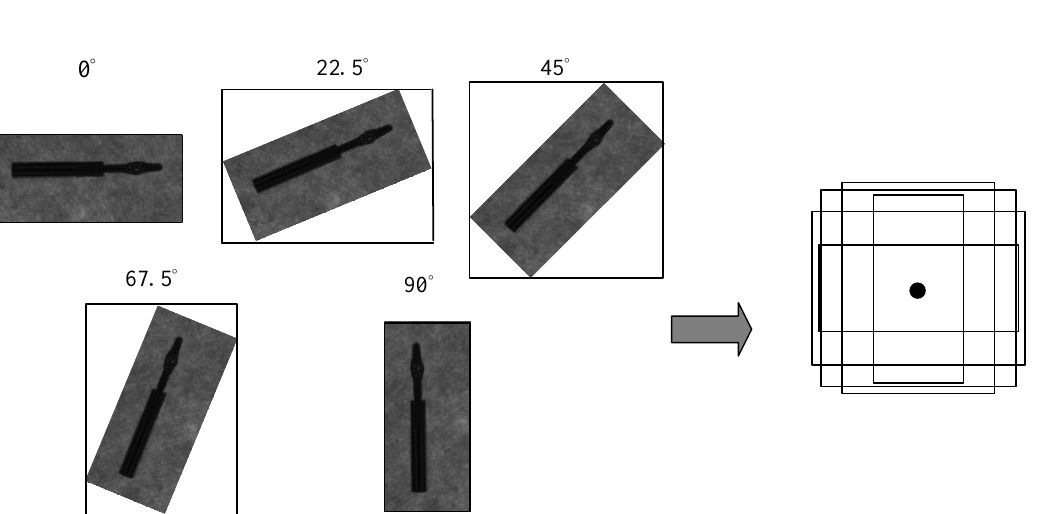
Figure 5. Initial candidate frame selection of precision parts.